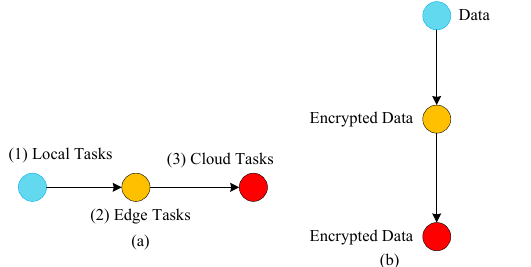
Figure 3. Workflow applications on distributed mobile ege cloud networks in Proposed